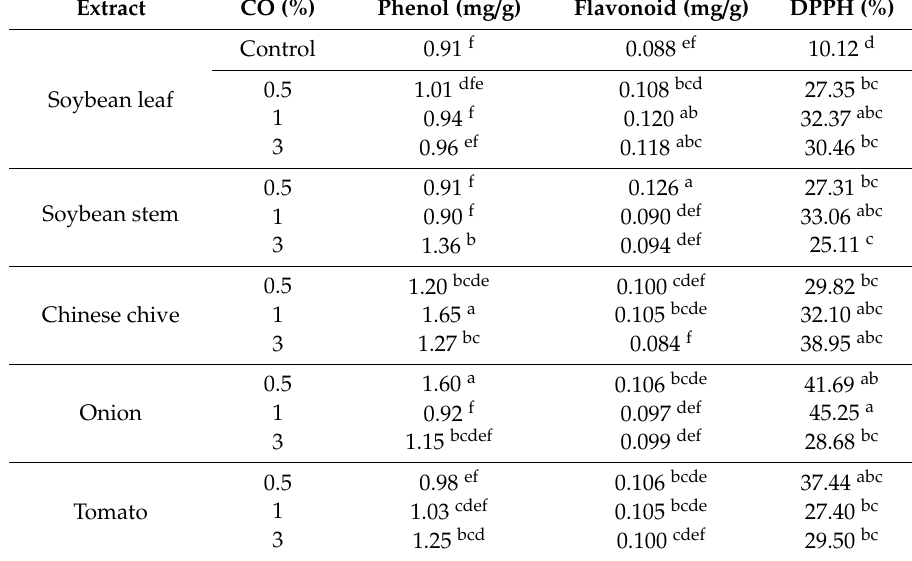
Table 4. Total phenol, total flavonoid contents and DPPH radical scavenging activity in Peucedanum japonicum leaves treated with plant